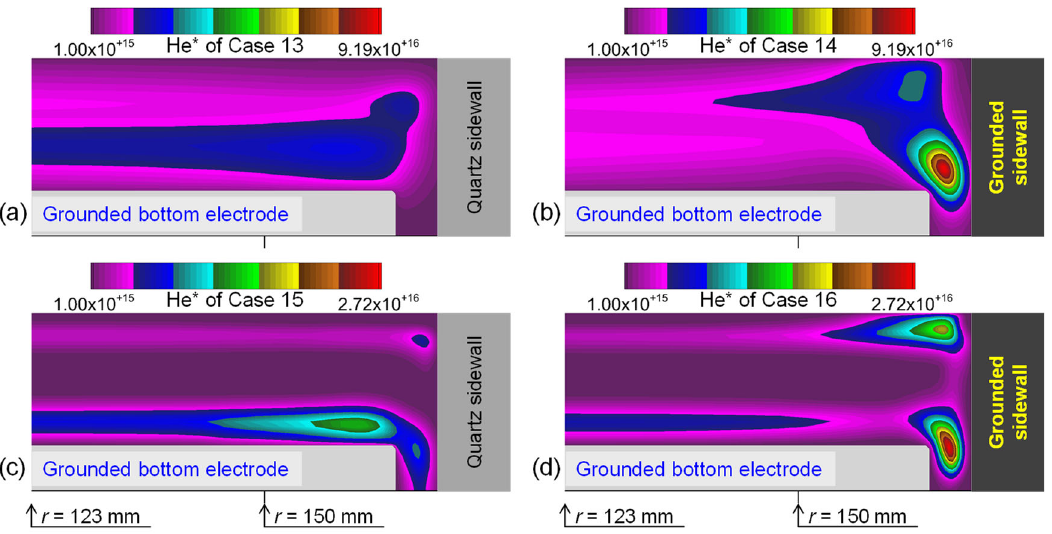
Figure 12. The spatial profiles of the time ‐ averaged He* density (m − 3 ) ( a ) for Case 13 ( b ) for Case 14, ( c ) for Case 15, and ( d ) for Case 16. ( c ) for Case 15, and ( d ) for Case